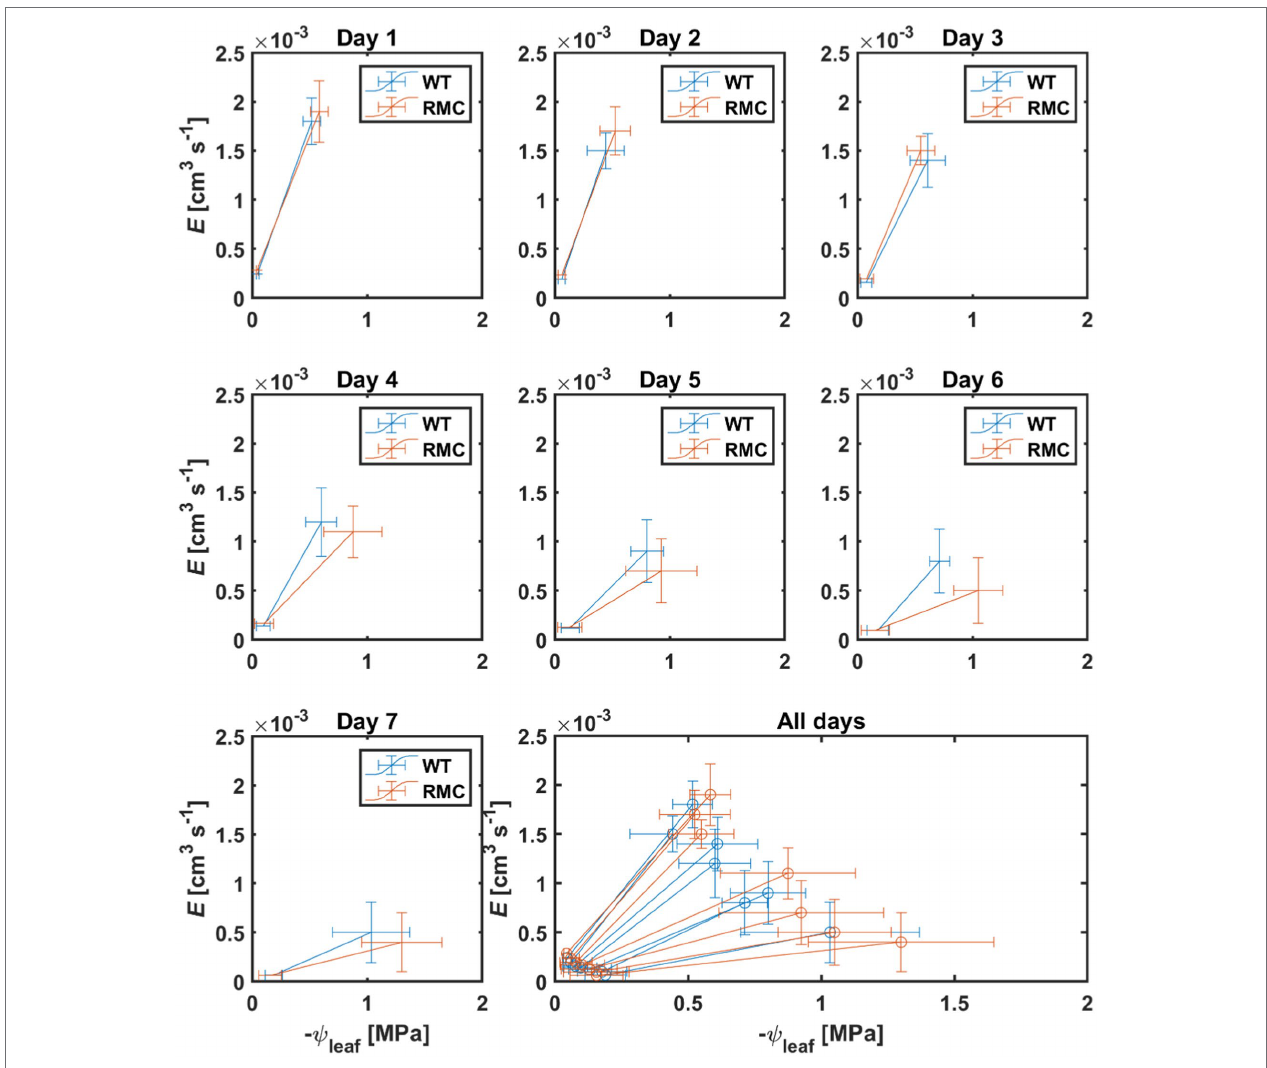
FIGURE 4 | Relation between transpiration rate ( E ) and leaf water potential ( ψ leaf ) during soil drying. Subplots show the relation on daily basis after last irrigation. As soil progressively dried, the RMC plants showed lower E and more negative ψ leaf on the same day compare to WT. n =